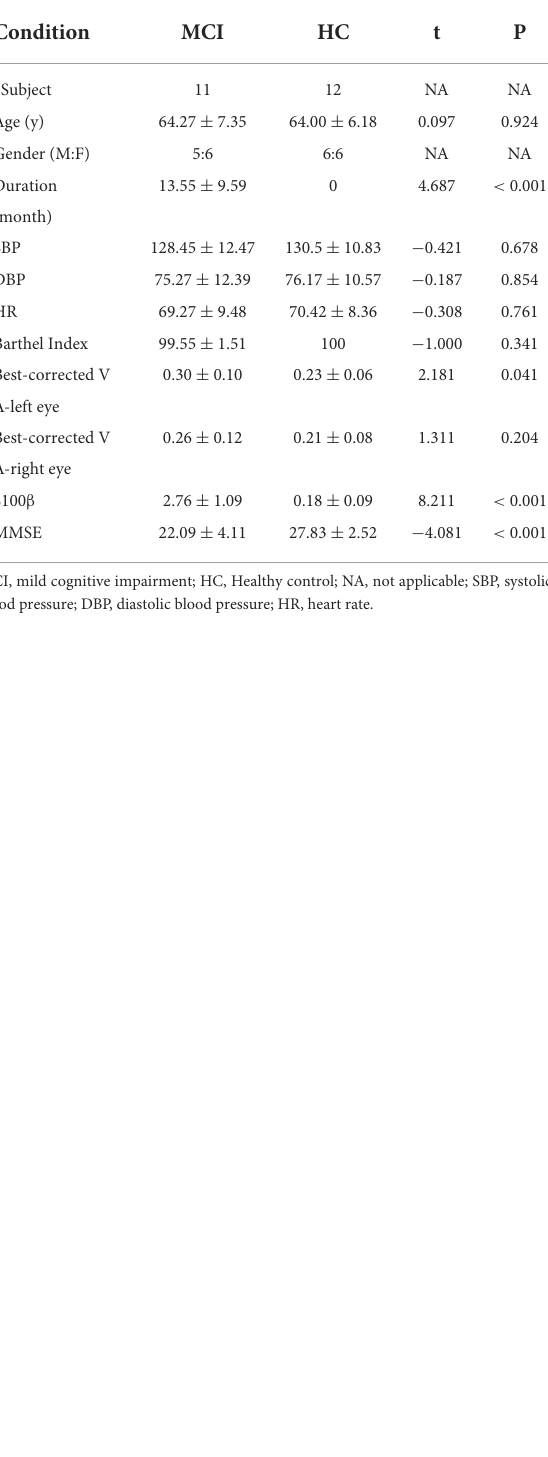
TABLE 2 Demographic characteristic of the enrolled